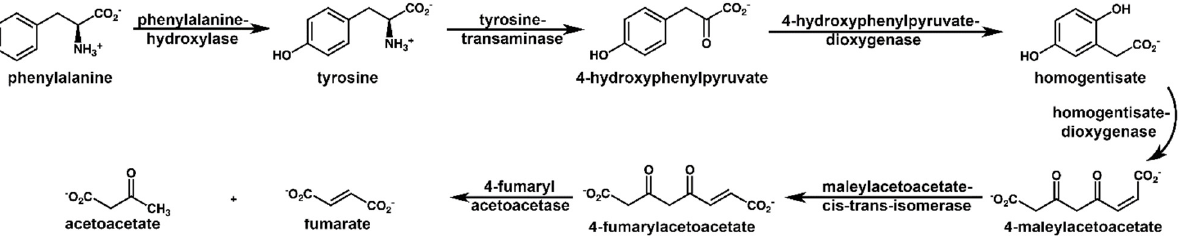
Figure 1. Phenylalanine and tyrosine degradation pathway (KEGG module hsa_M00044); concerning AKU, the critical step is opening the aromatic ring of homogentisate, catalyzed by the enzyme homogentisate dioxygenase (HGD), resulting in the acyclic 4-maleylacetoacetate. In AKU, variants of the HGD gene lead to a dysfunctional enzyme and subsequent substrate accumulation, leading to the formation of a dark pigment (the ochronotic pigment).